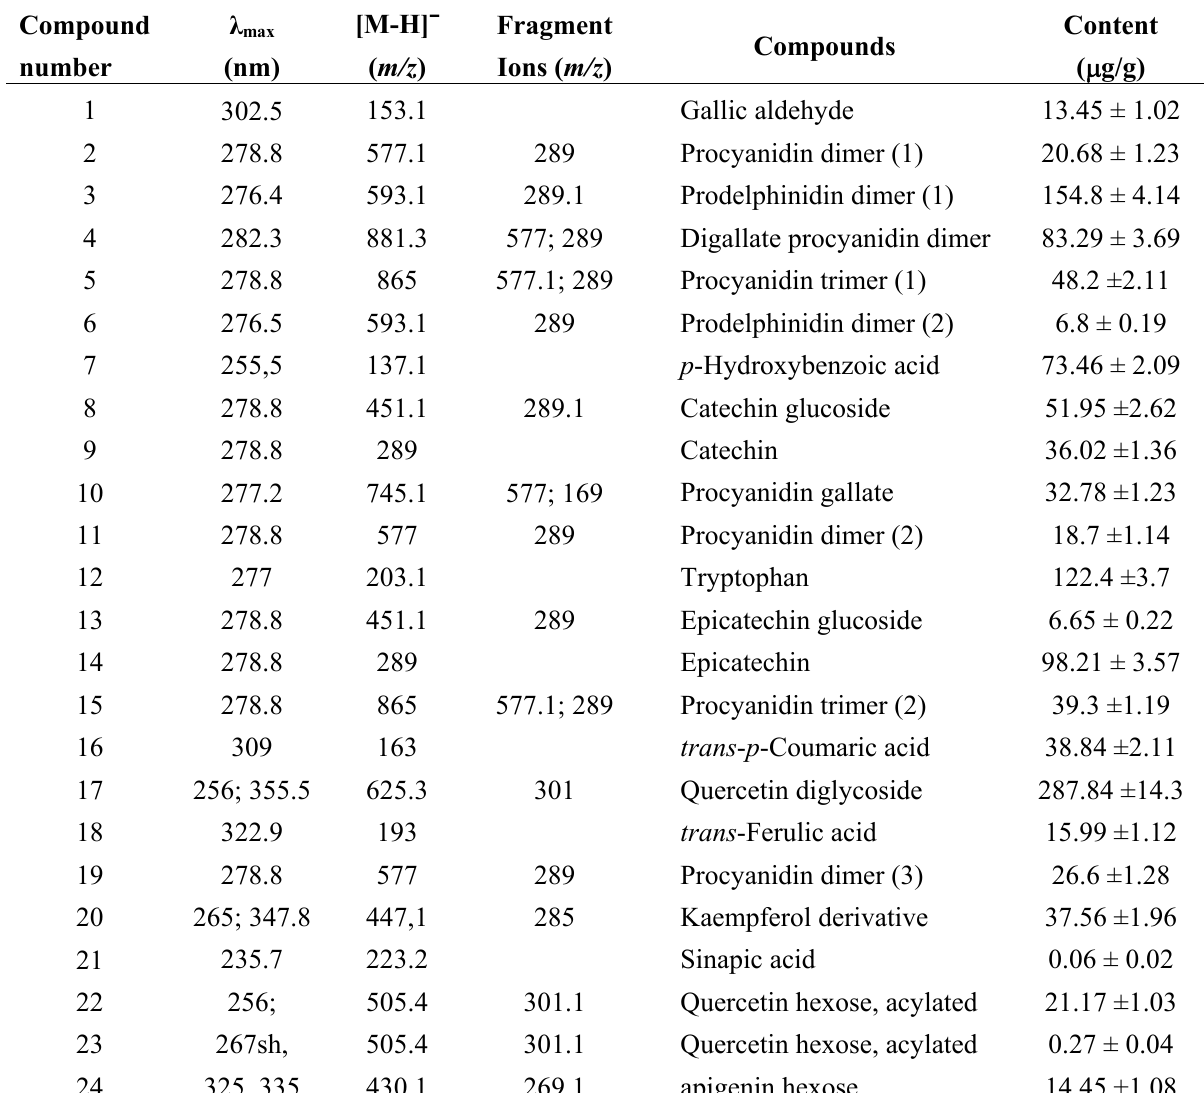
Table 2. Phenolic compounds identified by HPLC-PAD and HPLC-ESI-MS in a red lentil acetonic